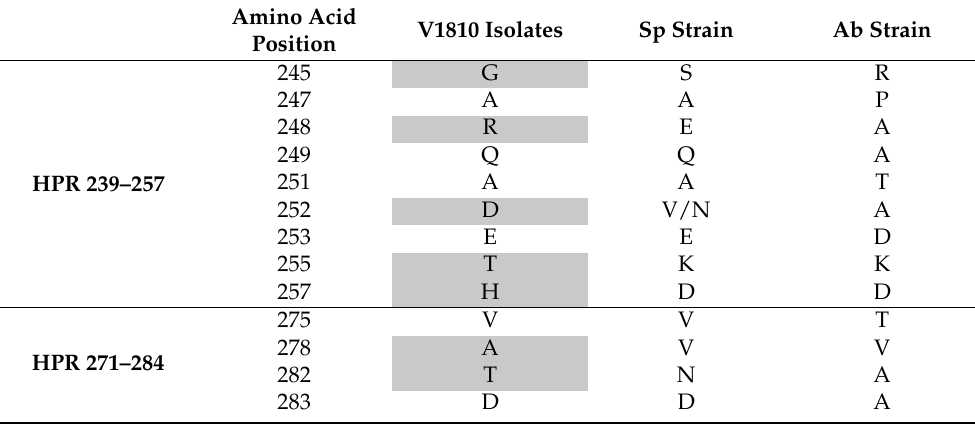
Figure 2. Analysis of the VP2 protein sequences of the new Scottish IPNV isolates at the antigenic site. The new Scottish isolates V1810–4, and V1810–6 amino acid sequences were aligned with Scottish isolates of serotype Sp or Ab with MUSCLE. The sequence was annotated manually in Geneious Prime v.2021.0.3 [32]. Zoom representation of the VP2 protein at the antigenic site. The antigenic site is contained in the VP2 protein (colored in clear blue), HPR regions are colored in dark blue. Amino acid residues variation is highlighted in blue on the sequences. Table 1. Amino acid residues present within the antigenic site of the VP2 proteins of the V1810 isolates compare to the Sp and Ab strains. Unique amino acid residues to the V1810–4 and V1810–6 isolates are highlighted in gray. Specific amino acid residues that seem unique to the serotype Sp or Ab can also be observed (amino acid one-letter code used).